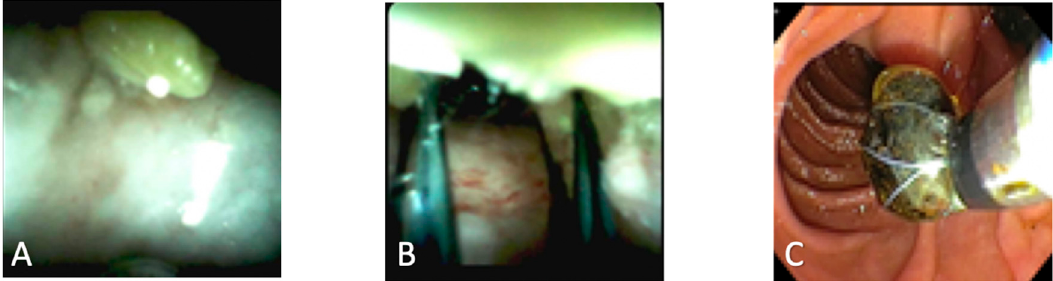
Figure 1. ( A ) Intrahepatic bile duct stone; ( B ) Positioning of the SpyGlass basket accessory around bile duct stone; ( C ) Removal of bile duct stone using SpyGlass basket accessory.